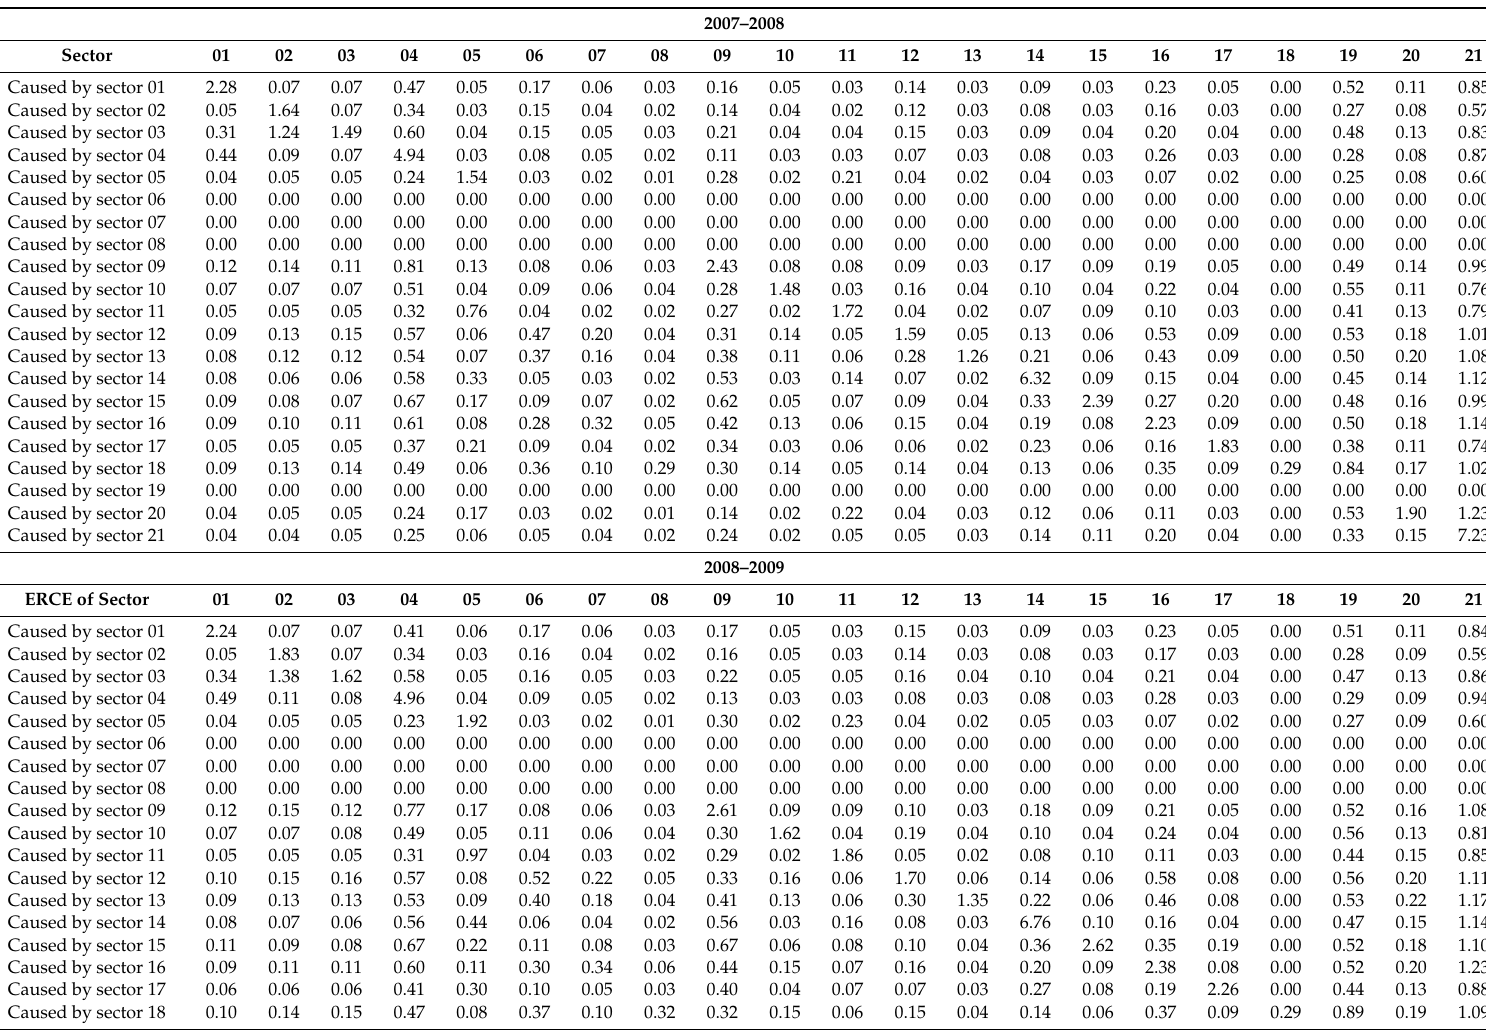
Table A2. The ERCE embodied in the CSFAI consumed by each sector caused by a unit of final demand increase in a specific sector in